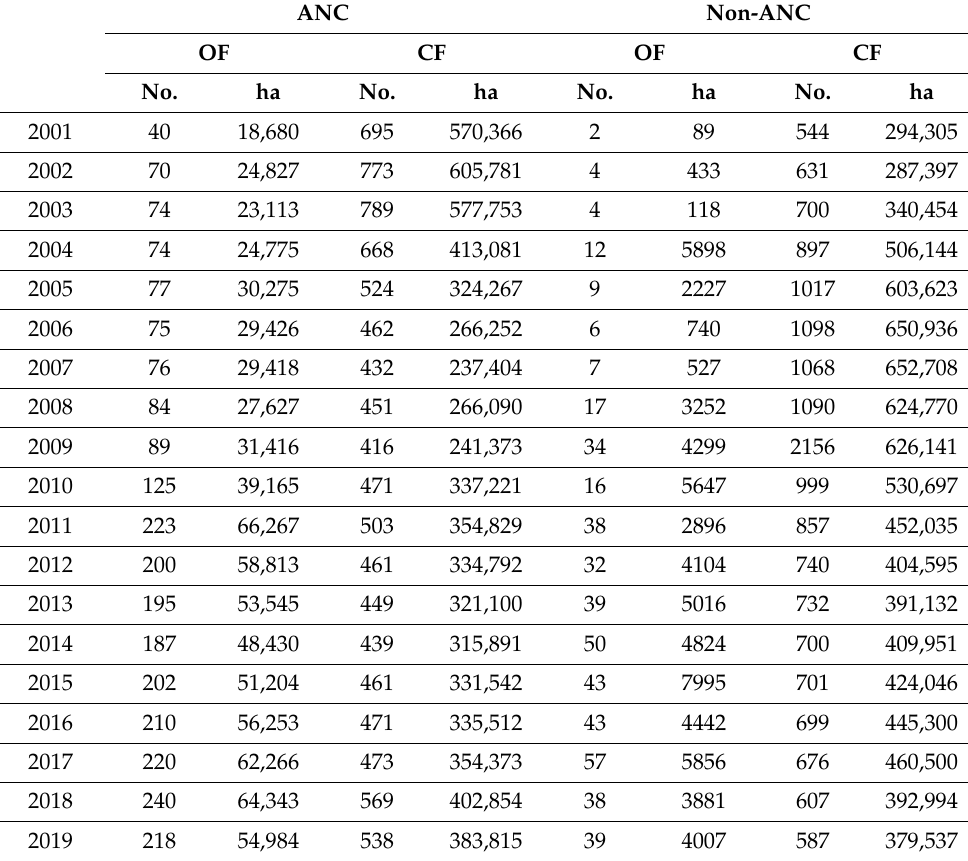
Table 1. Number of organic (OF) and conventional farms (CF) in the research sample and their acreage of agricultural land with division into ANC (Areas with Natural Constraints) and non-ANC. ANC Non-ANC OF CF OF CF No. ha No. ha No. ha No.